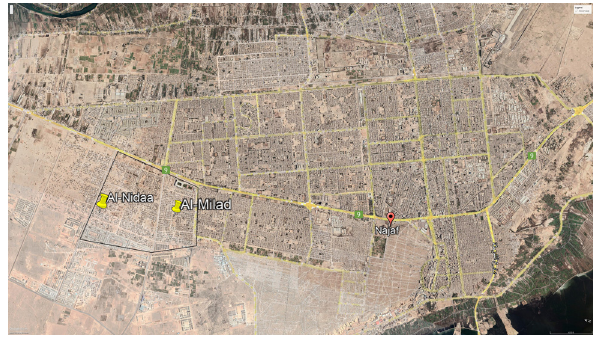
Figure 1: Area of study within Al - Najaf